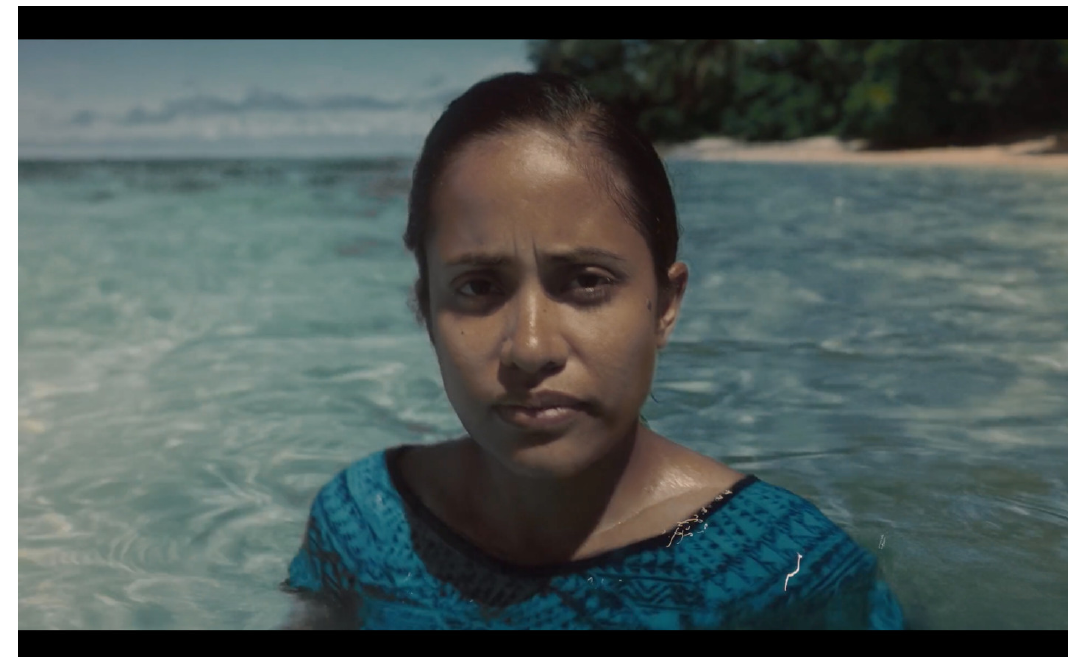
Figure 1: Rise: From One Island to Another (Jetñil-Kijiner and Niviâna 2019). Source: https://350.org/rise-from-one-island-to-another/. Image courtesy of the